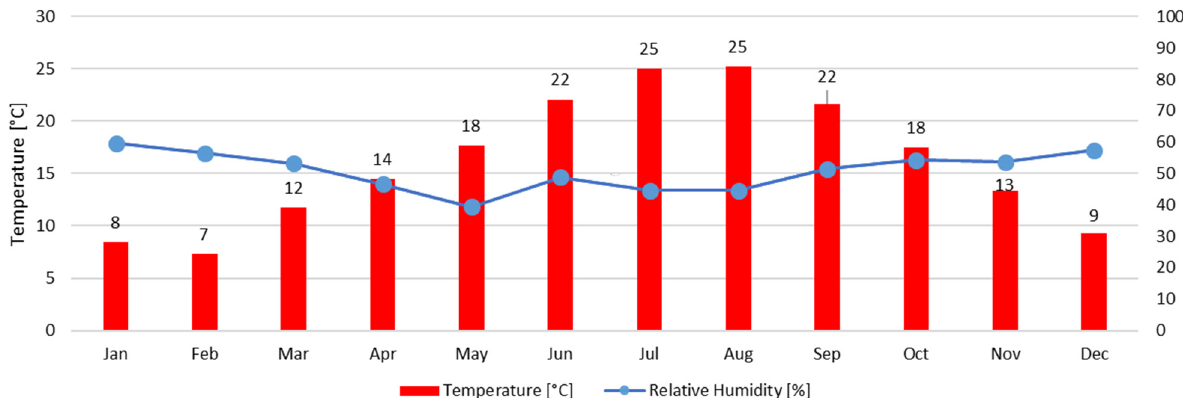
Figure 13. Rome t and r.h. during the average year.